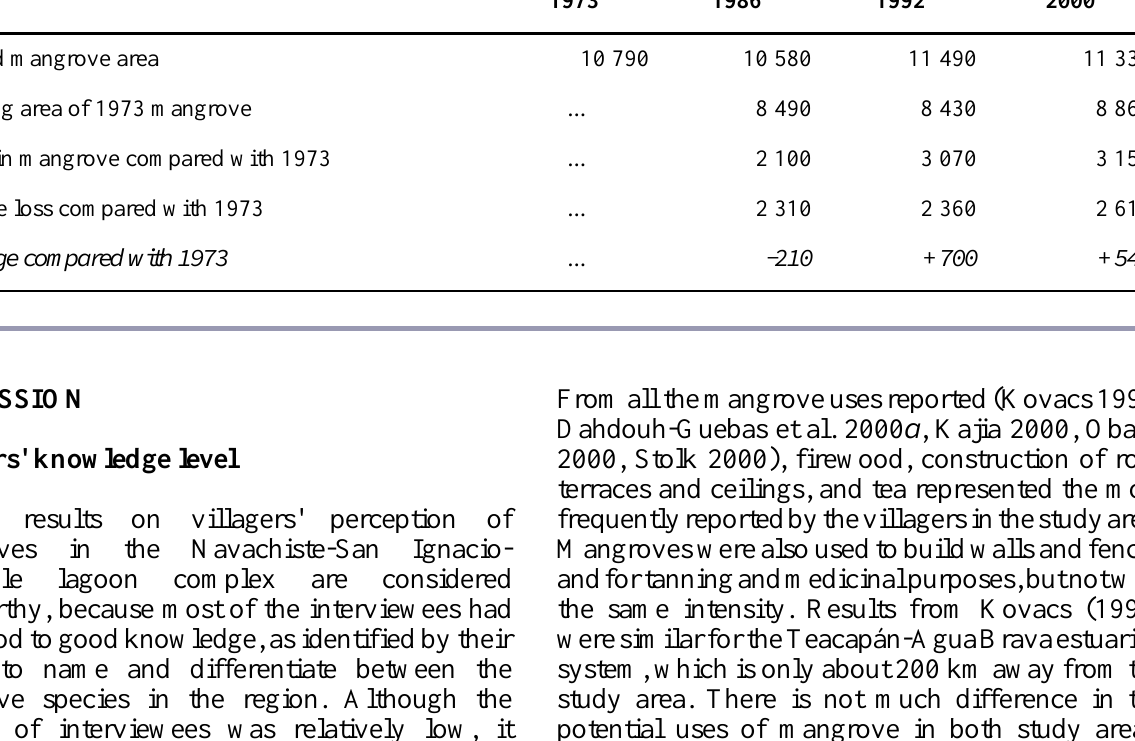
Table 2. Matrix representing a pixel-by-pixel comparison between the areas (ha) of mangrove forest from 1973, 1986, 1992, and 2000 (figures are rounded to the nearest 10). Estimated mangrove area 10 790 10 580 11 330 Remaining area of 1973 mangrove ... 8 490 8 430 8 860 Increase in mangrove compared with